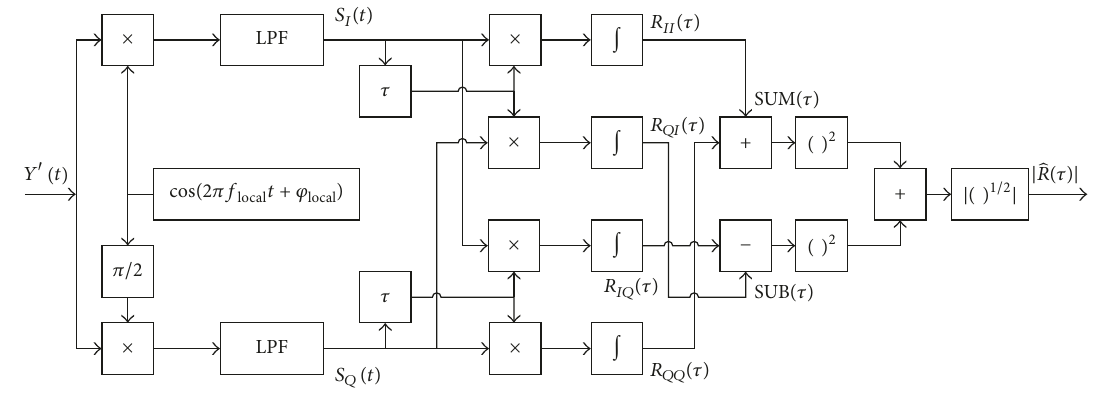
Figure 4: The overall process of the quadrature channel